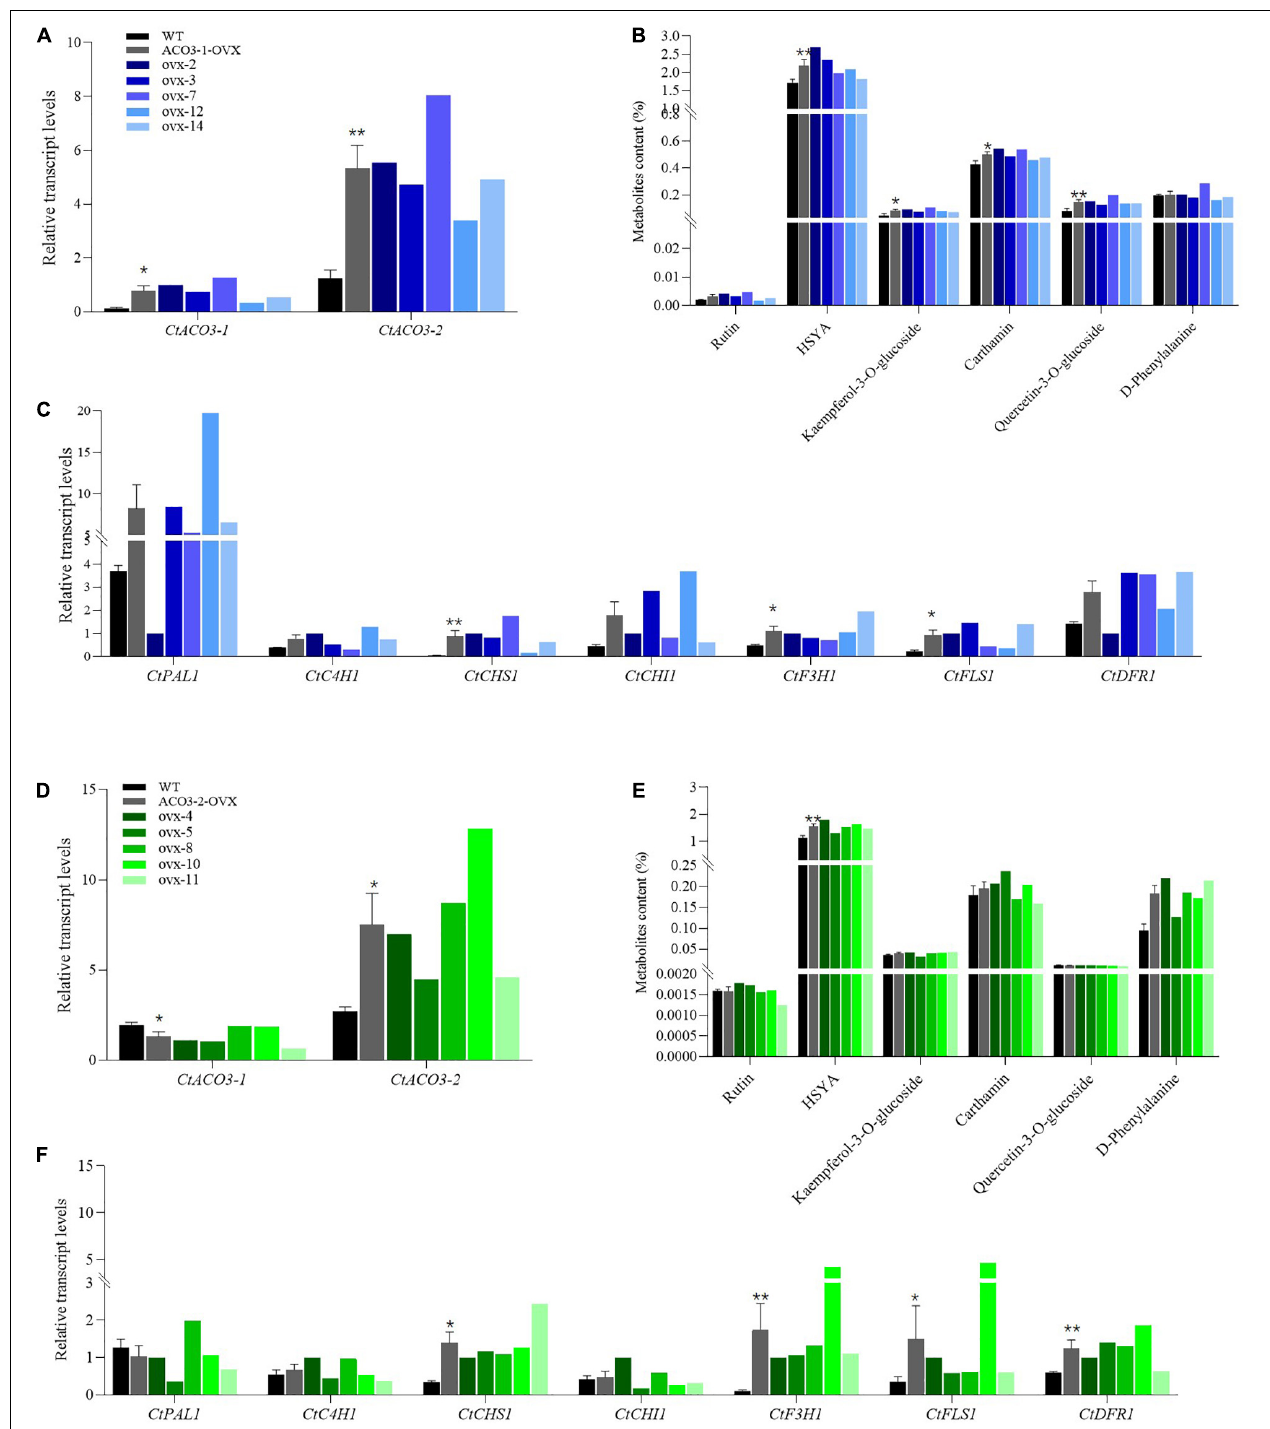
FIGURE 3 | Stimulatory effect of Ct ACO3-1 overexpression and Ct ACO3-2 overexpression on main active compounds content in safflower. (A) Relative expression levels of CtACO3-1 and CtACO3-2 in WT and Ct ACO3-1 overexpression transgenic lines determined by quantitative PCR (qPCR). (B) Ultra-high performance liquid chromatography with quadrupole time-of-flight mass spectrometry (UPLC-QTOF-MS) analysis of main active compounds content in WT and Ct ACO3-1 overexpression transgenic lines. (C) The expression levels of flavonoid-related genes in WT and Ct ACO3-1 overexpression transgenic lines determined by qPCR. (D) The relative expression levels of CtACO3-1 and CtACO3-2 in WT and Ct ACO3-2 overexpression transgenic lines determined by qPCR. (E) UPLC-QTOF-MS analysis of main active compounds content in WT and Ct ACO3-2 overexpression transgenic lines. (F) The expression levels of flavonoid-related genes in WT and Ct ACO3-2 overexpression transgenic lines determined by qPCR. Data were expressed as mean ± SEM ( n = 3), ** p < 0.01, and * p < 0.05.